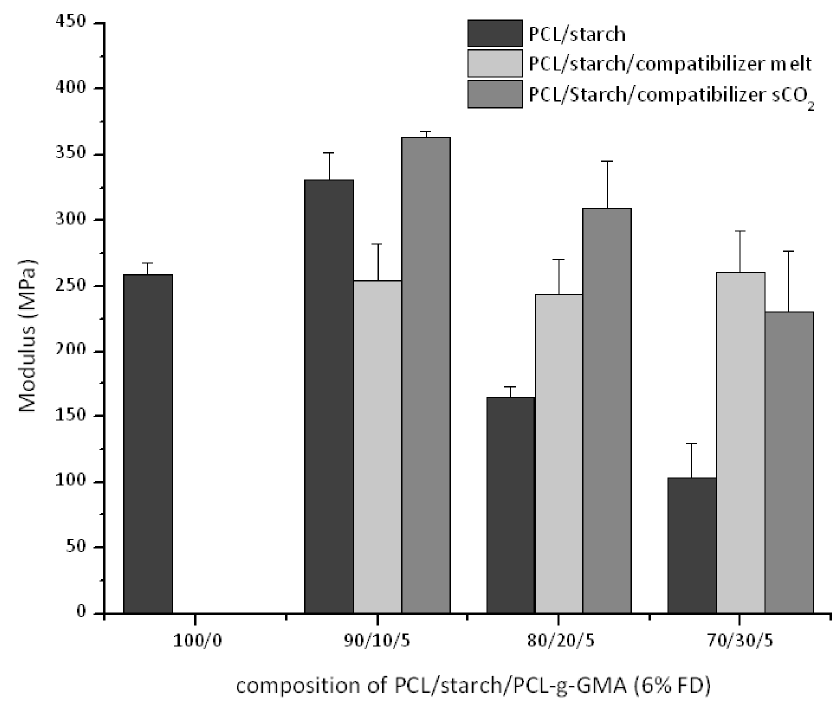
Figure 12. Modulus for ternary PCL/Starch/PCL- g -GMA blends.